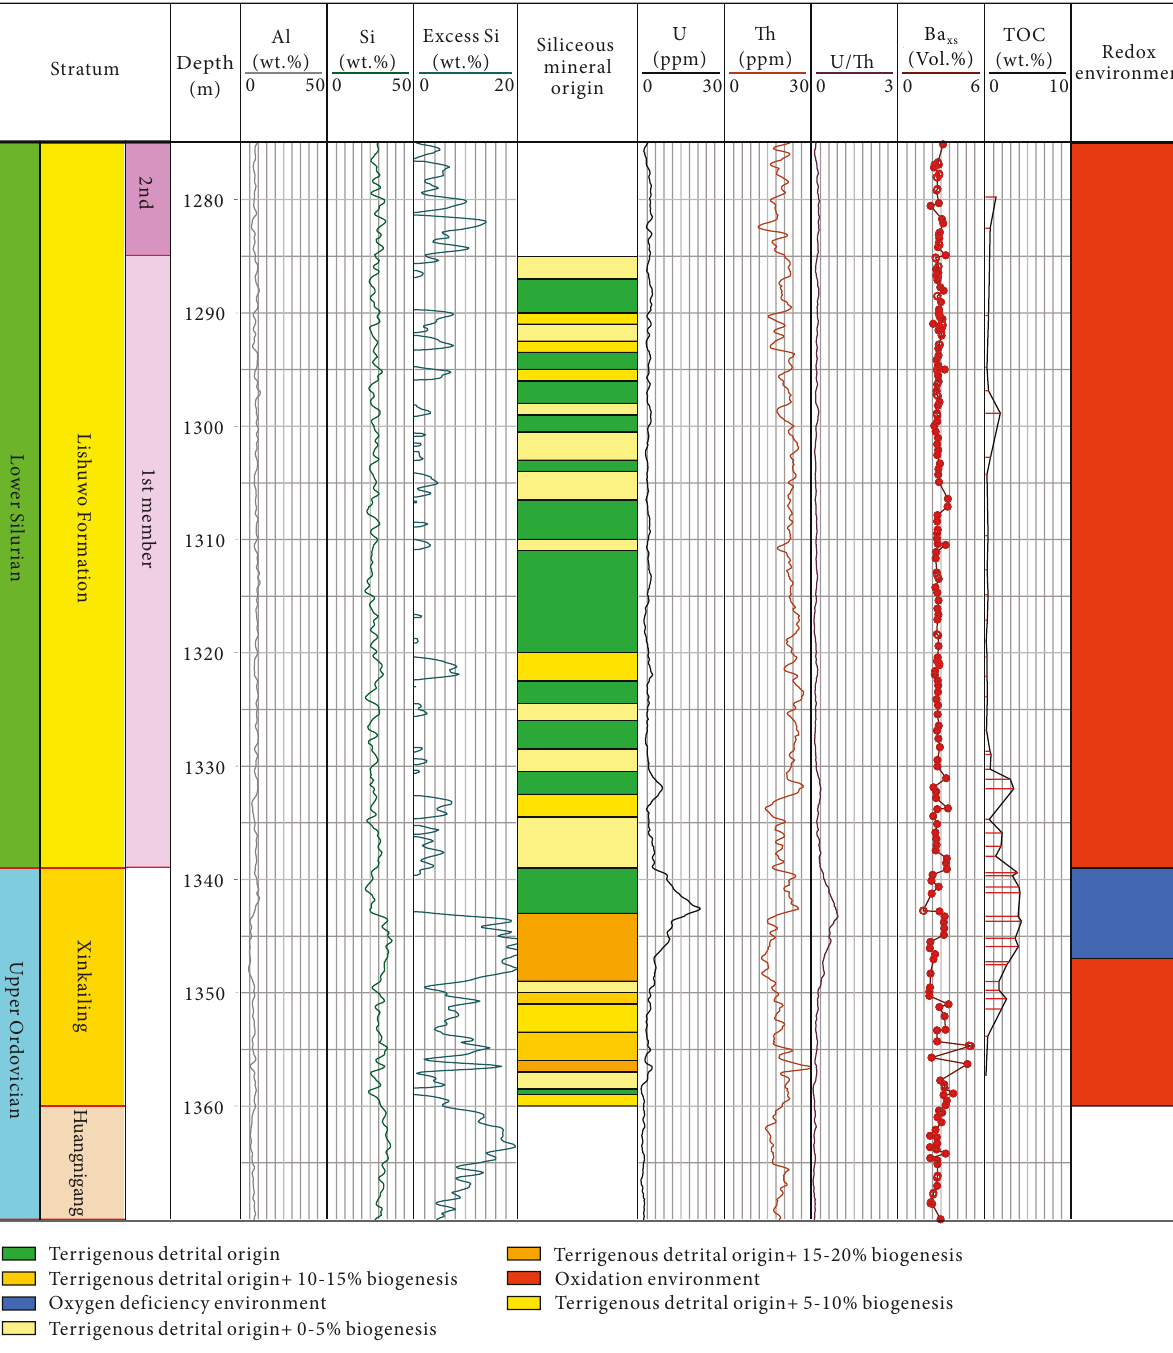
) and TOC content of the upper Ordovician xs